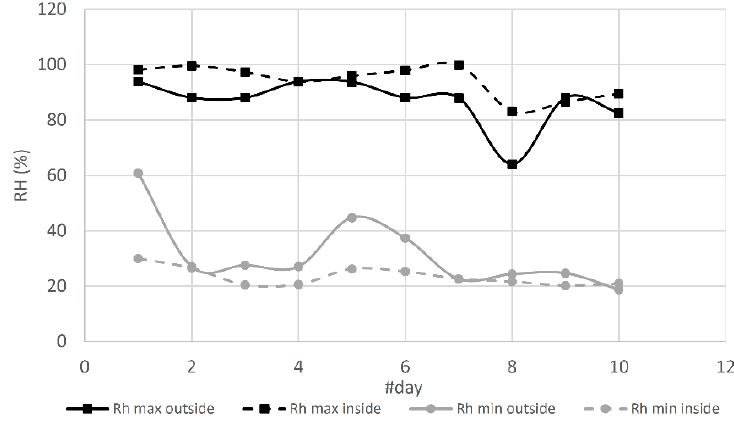
Figure 4. Relative humidity distribution in the prototype (outside and inside).